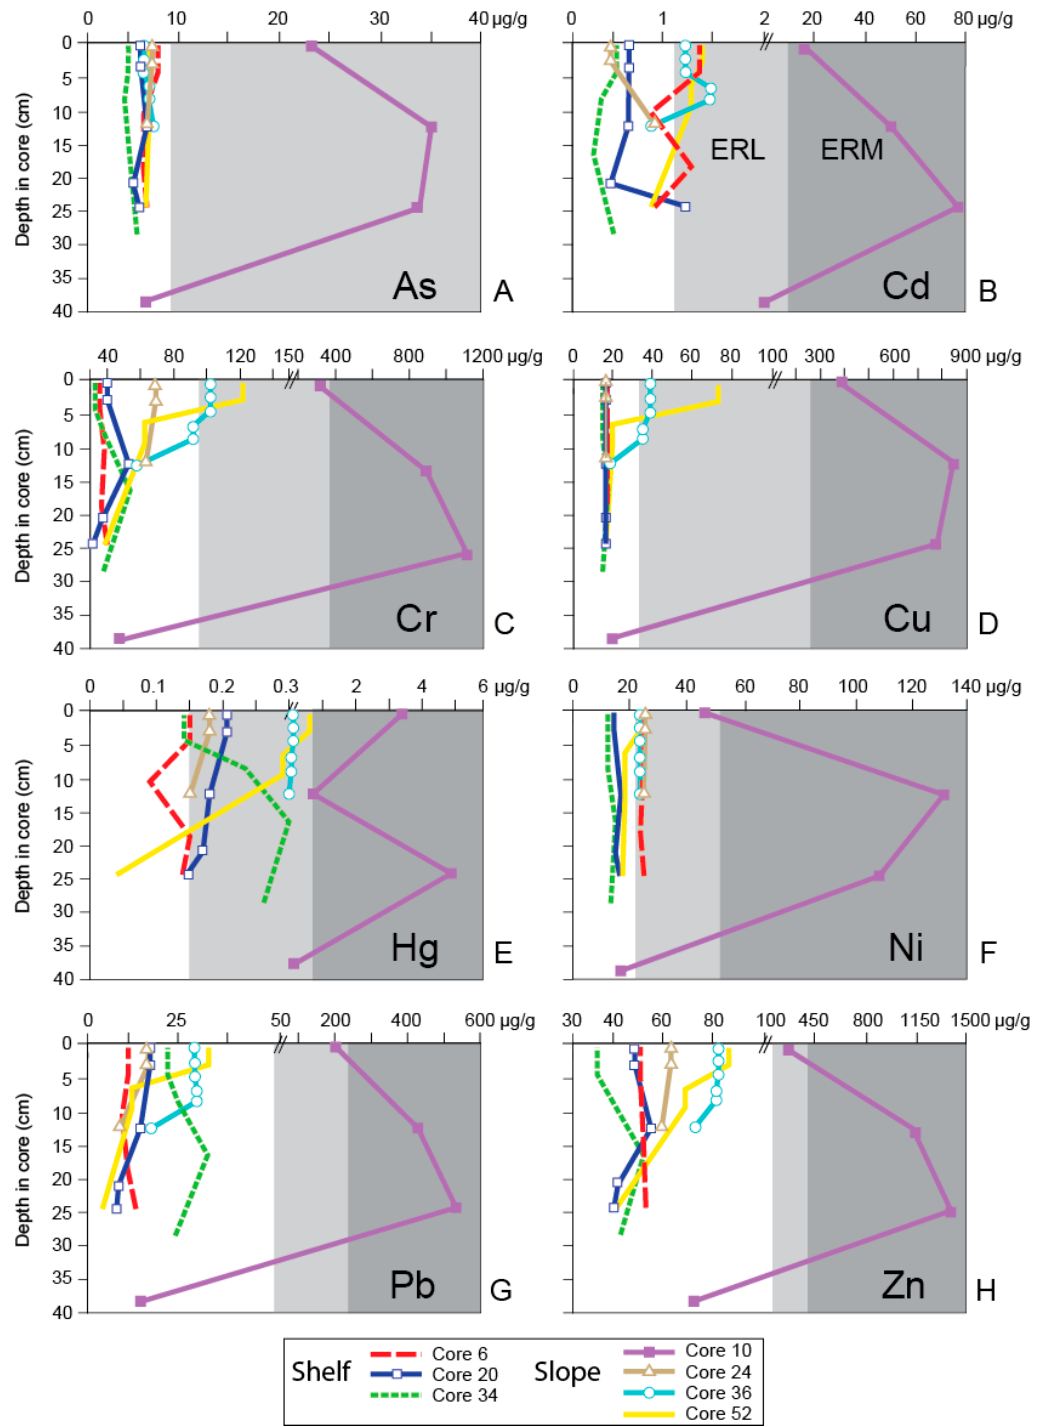
Figure 5. Relative abundance (in µg/g) of trace metals with depth in seven cores. Cores 6, 20, and 34 were obtained on the shelf and cores 10, 24, 36, and 52 were obtained on the slope. ( A ) As = arsenic, ( B ) Cd = cadmium, ( C ) Cr = chromium, ( D ) Cu = copper, ( E ) Hg = mercury, ( F ) Ni = nickel, ( G ) Pb = lead, and ( H ) Zn = zinc. Effects range-low (ERL) values (light shading) and effects range-median (ERM) values (darker shading) as defined by Long et al. [83]. Note change in horizontal scale in all but ( B , F ).